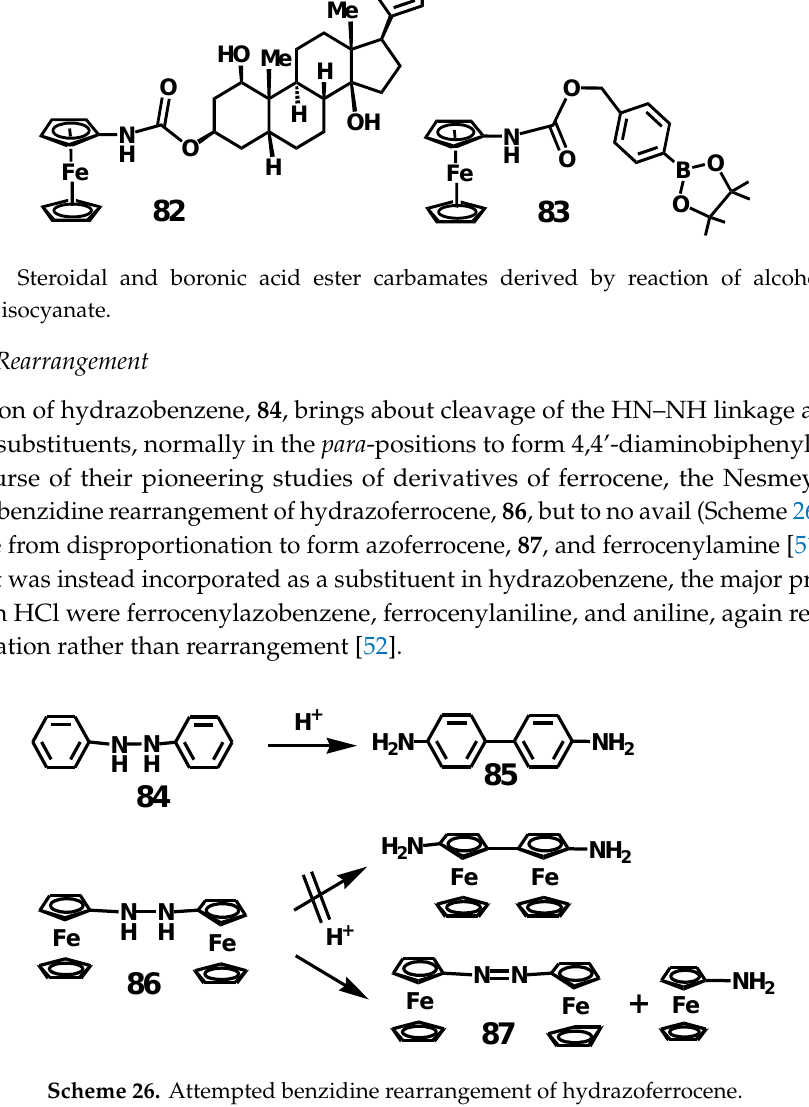
Scheme 26. Attempted benzidine rearrangement of